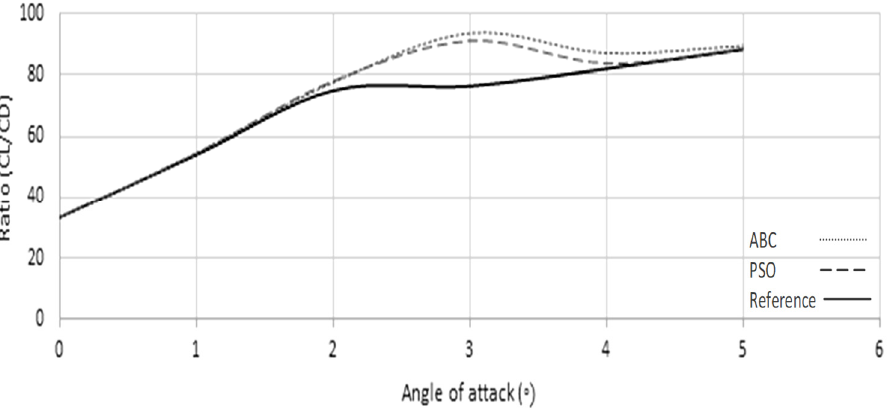
Figure 14. Results of the ABC and PSO optimized airfoils versus original UAV S45 airfoil.